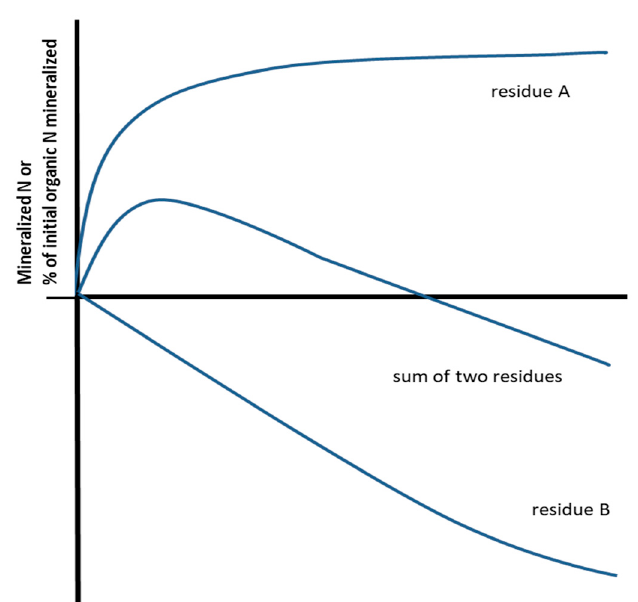
Figure 4. Illustration of late mineral N decrease obtained during the decomposition of a mixture (middle line) composed of two residues with very different N dynamics and no interaction: residue A would show net mineralization if decomposed separately and, residue B would show net immobilization.